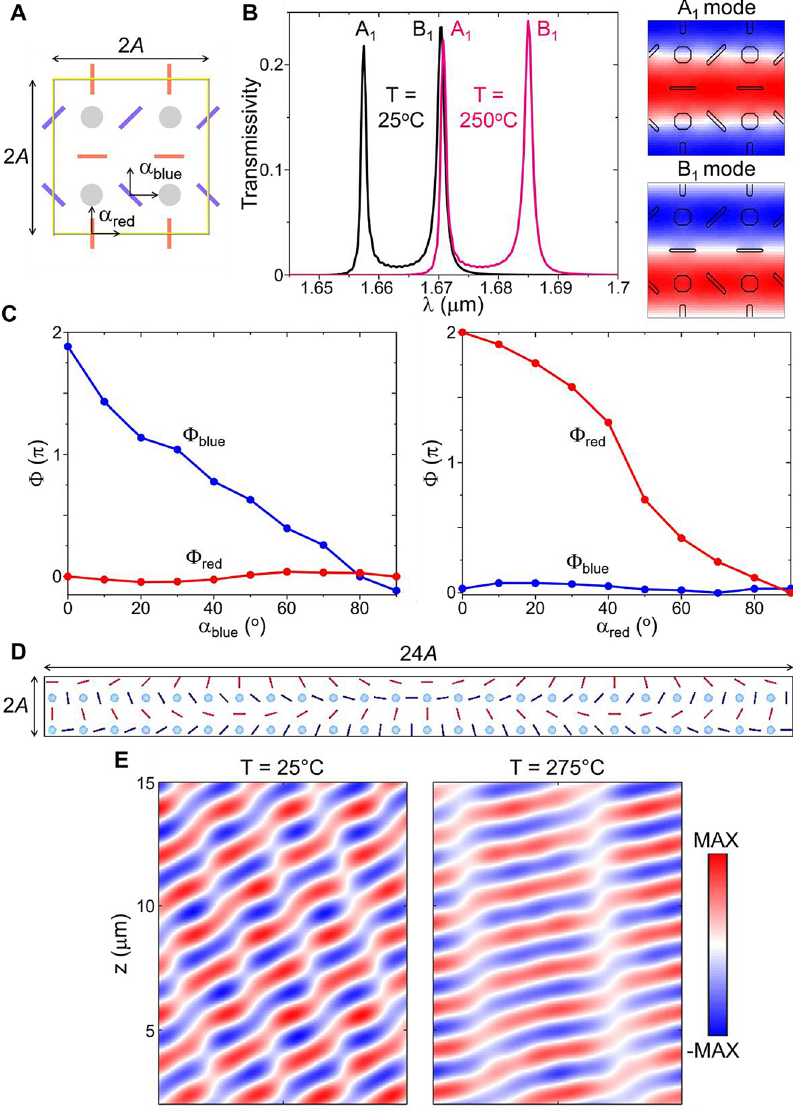
Figure 5: Design of a multifunctional wavefrontshapingthermo-opticmodulator in silicon. (A) Composite meta-unit with two orthogonal perturbations (red and blue). 250-nm-thicksiliconslab.Theunperturbed apertures with a diameter of 125 nm and the lattice constant is A = 900 nm. The colored rectangular apertures represent two types of perturbations and have a dimension of 175 nm × 25 nm. (B) Left panel: transmission spectra of the meta-unit for light of converted circular polarization at 25 ° C (black curve) and 250 ° C (magenta curve). Right panels: out-of-plane electric- fi eld components of the “ blue ” (A 1 type) and “ red ” (B 1 type) modes. (C) Geometric phases control by the red (right) and blue (left) apertures for the red and blue resonances, respectively. (D) One superperiod of a multifunctional beam de fl ector where red and blue apertures impart distinct phase gradients to the two modes. (E) Far fi eld electric- fi eld (real part) pro fi les at λ = 1.649 μ m of the multifunctional beam de fl ector at 25 and 275 °